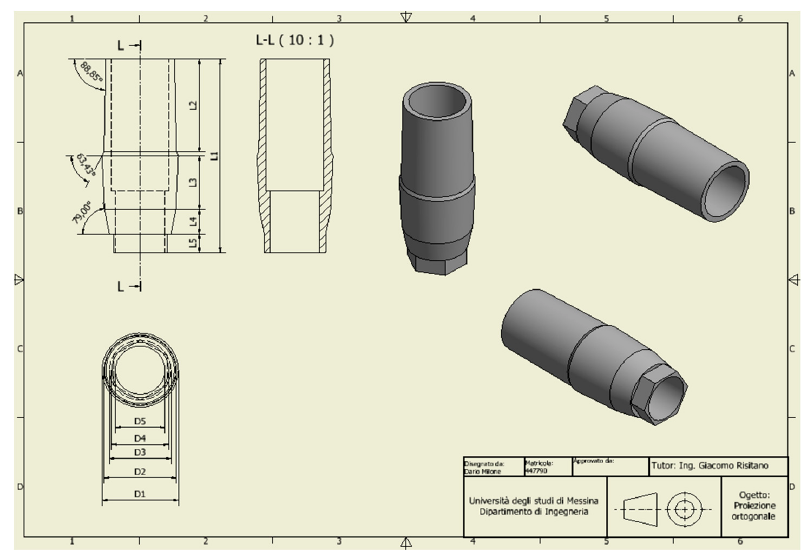
Figure 2. Dimensions of the fixture (Osstem ® TSIII) involved in the study.